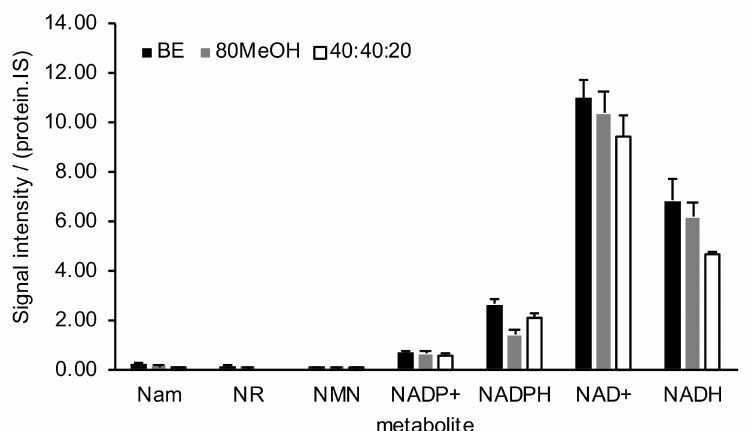
Figure 2. Comparison of 3 sample preparation procedures in detecting the NAD + metabolome of Hep G2 cells: biphasic extraction (BE), 80% cold methanol (80MeOH) and 40:40:20 with 0.1 M formic acid (40:40:20) extraction ( n = 5, average ± SD). Values expressed in ratios of LC-MS/MS signal intensity normalized to internal standard and total protein content (arbitrary units). Nam: nicotinamide; NR: nicotinamide riboside; NMN: nicotinamide mononucleotide; NADP + : nicotinamide adenine dinucleotide monophosphate; NADPH: nicotinamide adenine dinucleotide monophosphate, re- duced form; NAD + : nicotinamide adenine dinucleotide; NADH: nicotinamide adenine dinucleotide, reduced